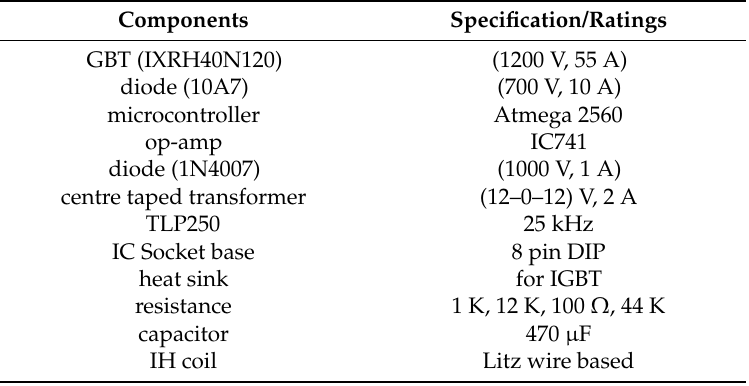
Table A1. List of components used for experimental design and their